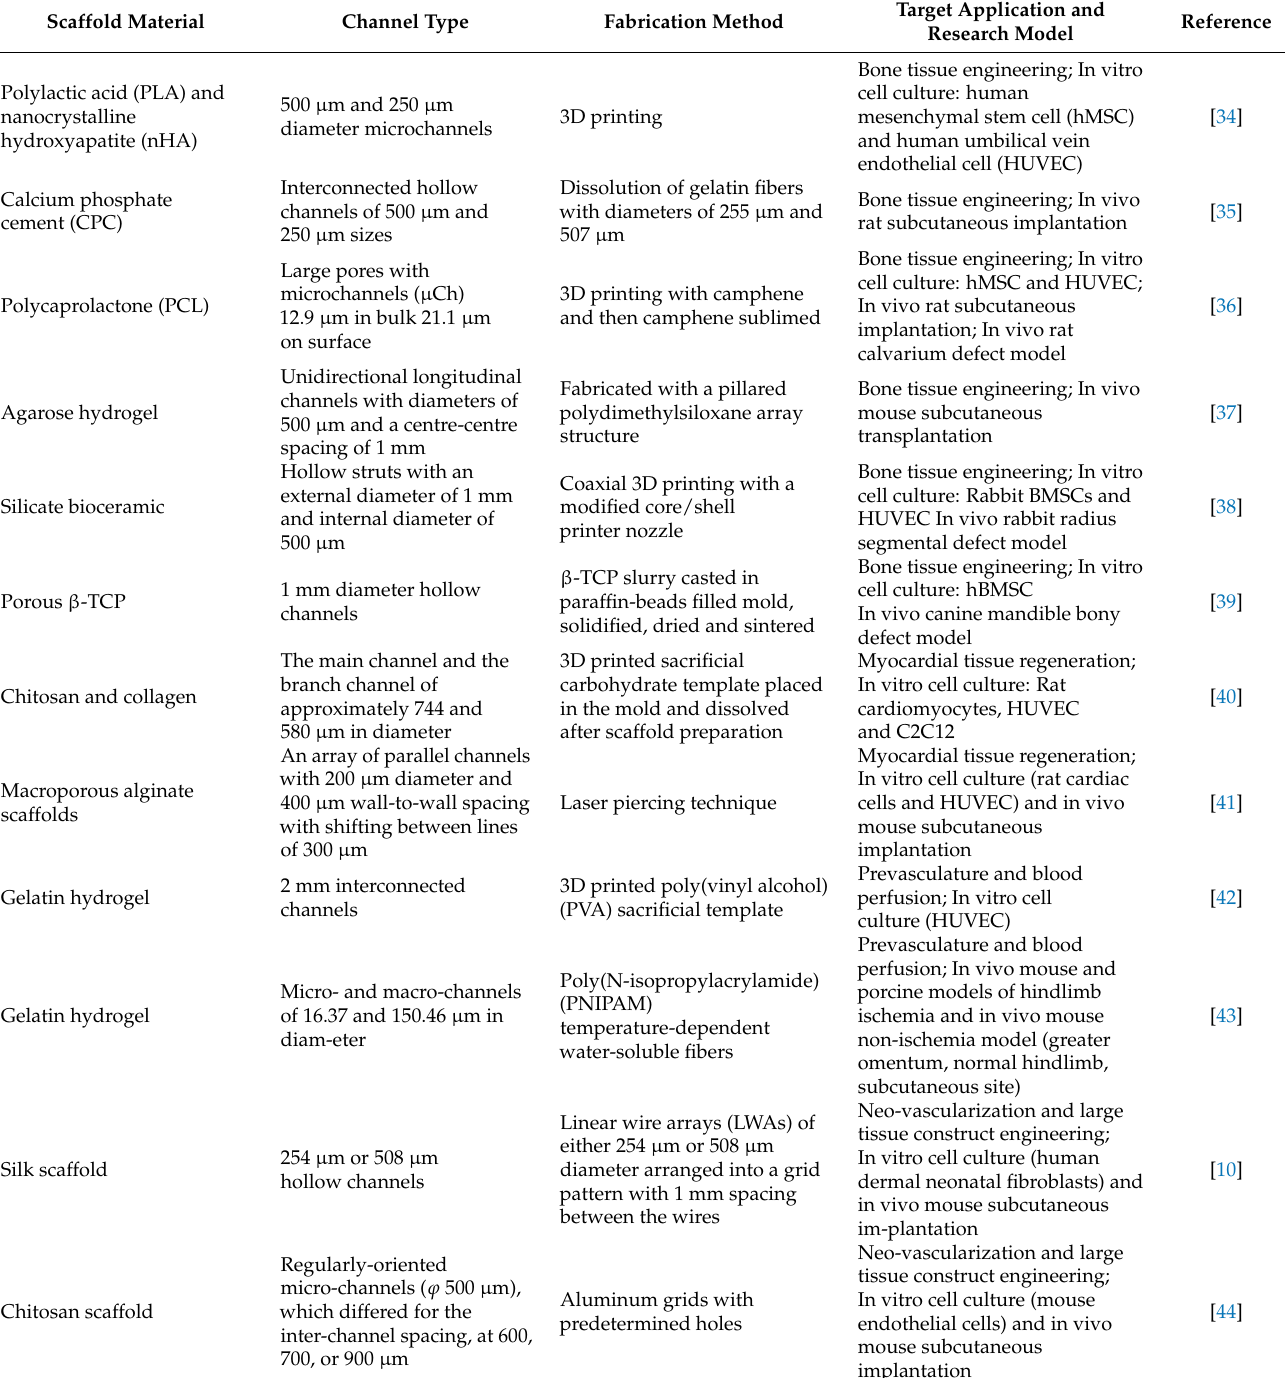
Table 1. List and overview of articles selected for